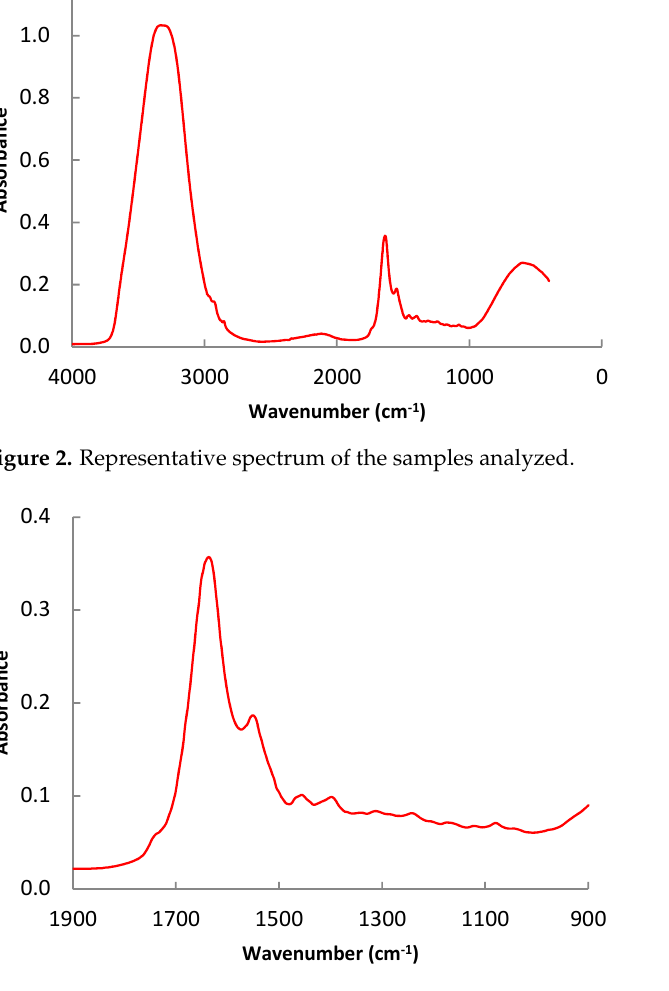
Figure 3. Detail of the representative spectrum in the region between 1900 and 900 cm − 1 .